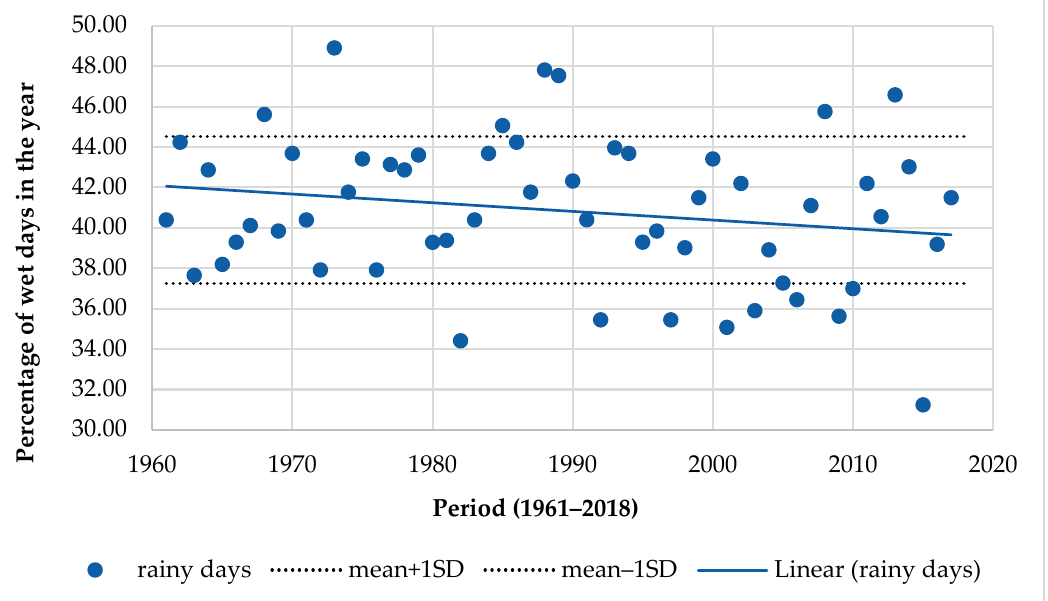
Figure 5. Temporal distribution of the PDU index (annual percentage of wet days) in the period from 1961 to 2018. Data from INMET station 82331, 2020. Elaborated by authors.